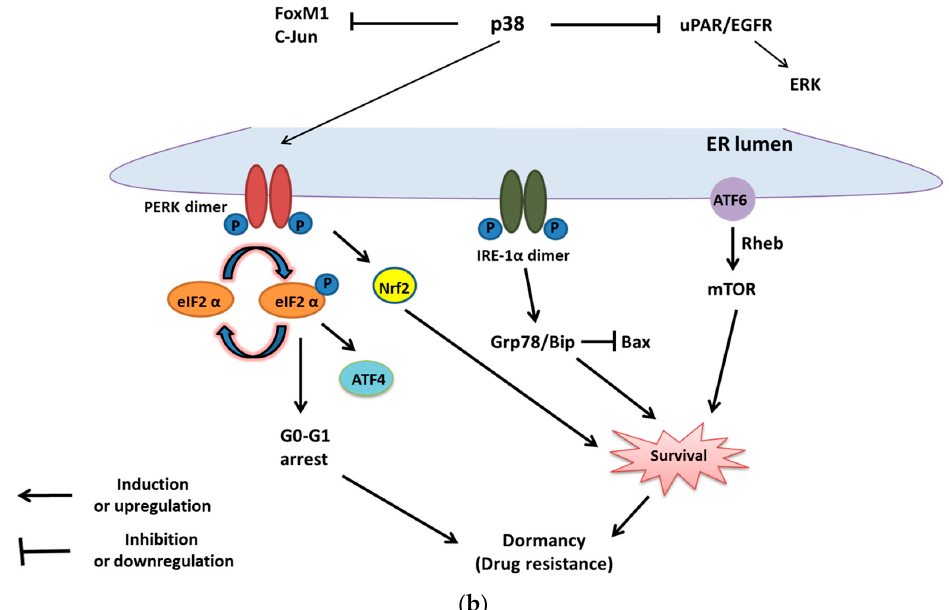
Figure 3. The role of dormancy in metastasis and chemoresistance of cancer cells. ( a ) Dormancy-regulated metastasis affected by the balance between p38 and ERK. When tumor cells disseminate, there are three different outcomes in different microenvironments. Firstly, with upregulation of MAPK p38 combined with decreasing ERK signals, tumor cells degenerate without metastasis during dissemination; Secondly, increasing ERK with decreasing MAPK p38 promotes metastasis; Thirdly, decreasing ERK with increasing p38 brings about metastatic cells dormancy; ( b ) UPR-induced dormancy is associated with cancer cell survival and chemoresistance. MAPK p38 can suppress FoxM1, c-Jun and the uPAR (Urokinase-type plasminogen activator receptor) transcript, which is crucial for the activation of ERK. Furthermore, it can also trigger the downstream signaling of UPR. Activated PERK can phosphorylate elF2 α for the G0–G1 arrest and induce ATF4 for survival. Besides, phosphorylated elF2 α can trigger ATF4 for survival. Activated IRE-1 α can induce Grp78/Bip for survival as well as block the pro-apoptotic signal, Bax. Furthermore, ATF6 α can promote survival through the mTOR signaling pathway. Redrawn from Sosa et al. [48].